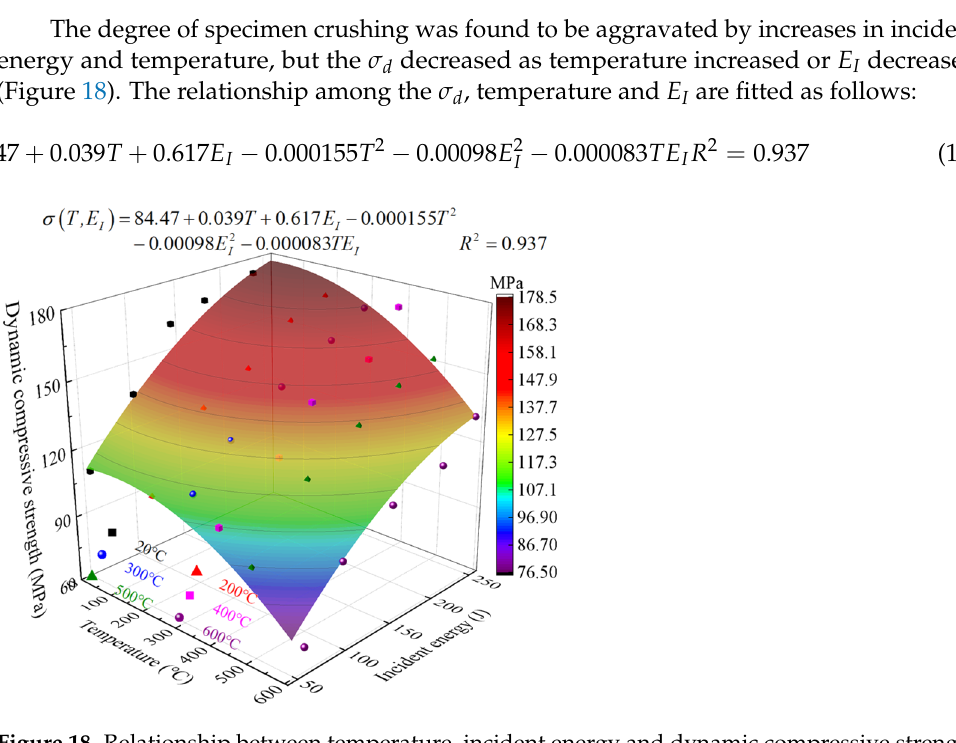
Figure 18. Relationship between temperature, incident energy and dynamic compressive strength of granite.